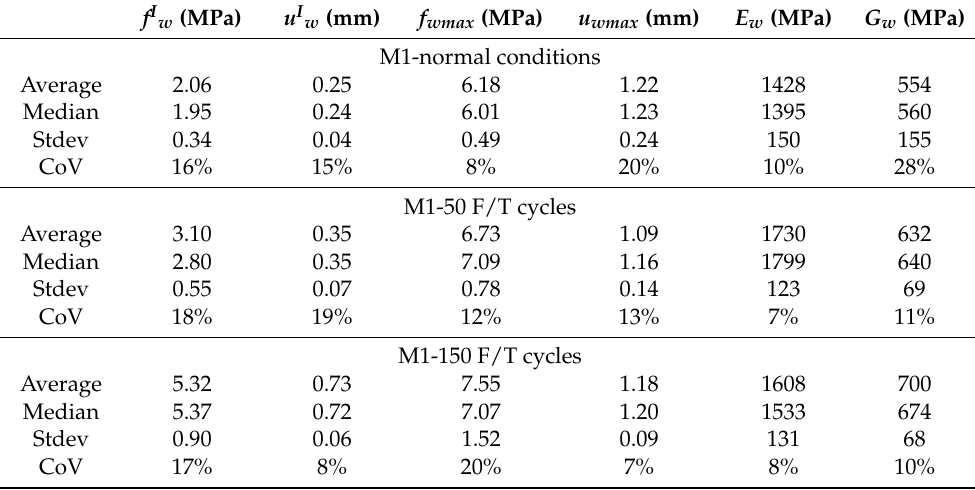
Table 1. Results of the compressive tests of the wallets M1